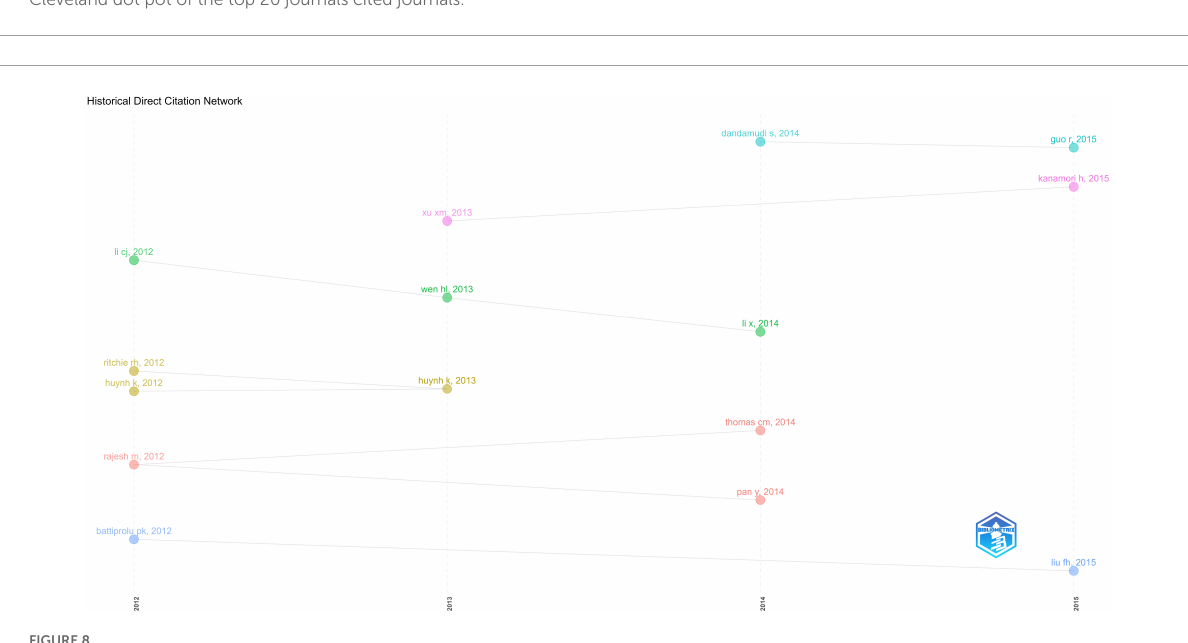
FIGURE7 Cleveland dot pot of the top 20 journals cited journals.